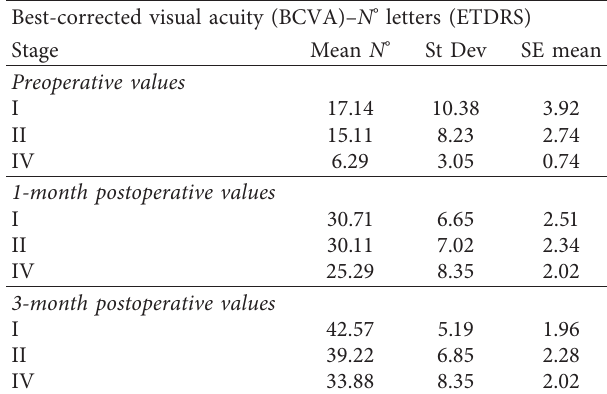
Figure 2: (a) OCT image showing stage IV IMH with a diameter of 580 μ m preoperatively. (b) Follow-up OCTscan at 3 months showing closed macular hole with restored ELM and IS/OS junction integrity. Table 1: Demographic characteristics and preoperative values. Parameter